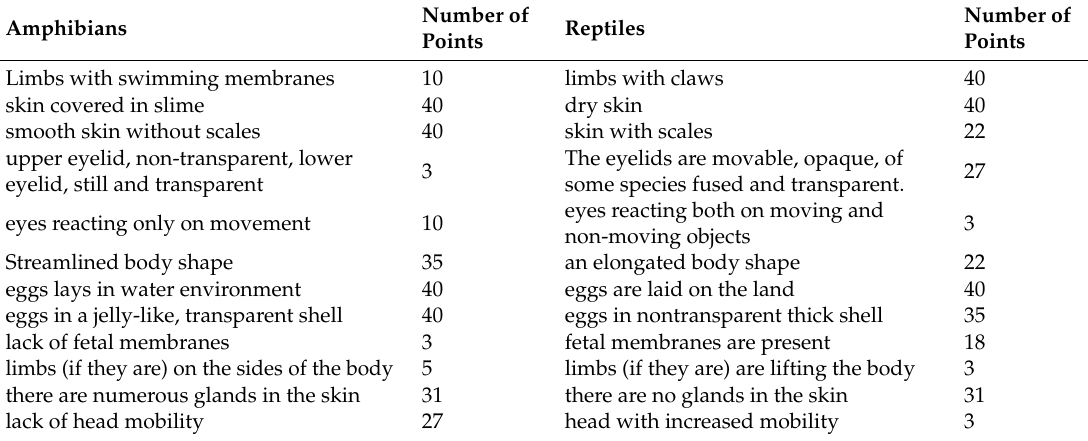
Table A4. Factors which students assigned as typical to amphibian or reptile in their environment during Task 2 (maximum points